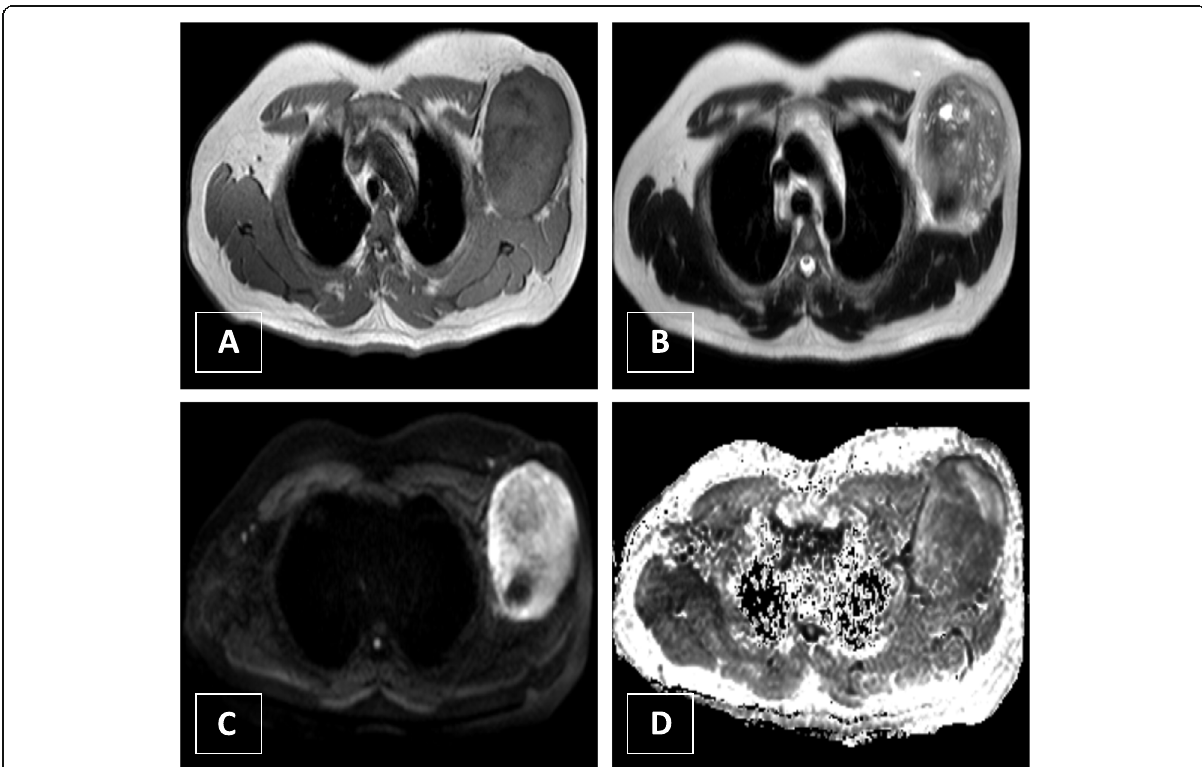
Fig. 3 A 29-year-old male patient presented with left lateral chest wall mass. MRI chest wall shows well-defined soft tissue mass compression the left lateral chest wall with no infiltration of the surrounding structures. The mass exhibits hypointense signal intensity in T1WI ( a ), heterogeneous signal intensity in T2 WI ( b ), and restricted diffusion in the form of high signal in diffusion ( c ) and low signal in ADC map ( d ). The ADC value was 0.9 ± 0.04 × 10 − 3 mm 2 /s, and the mass was pathologically proven to be a malignant peripheral nerve sheath tumor (spindle cell sarcoma)